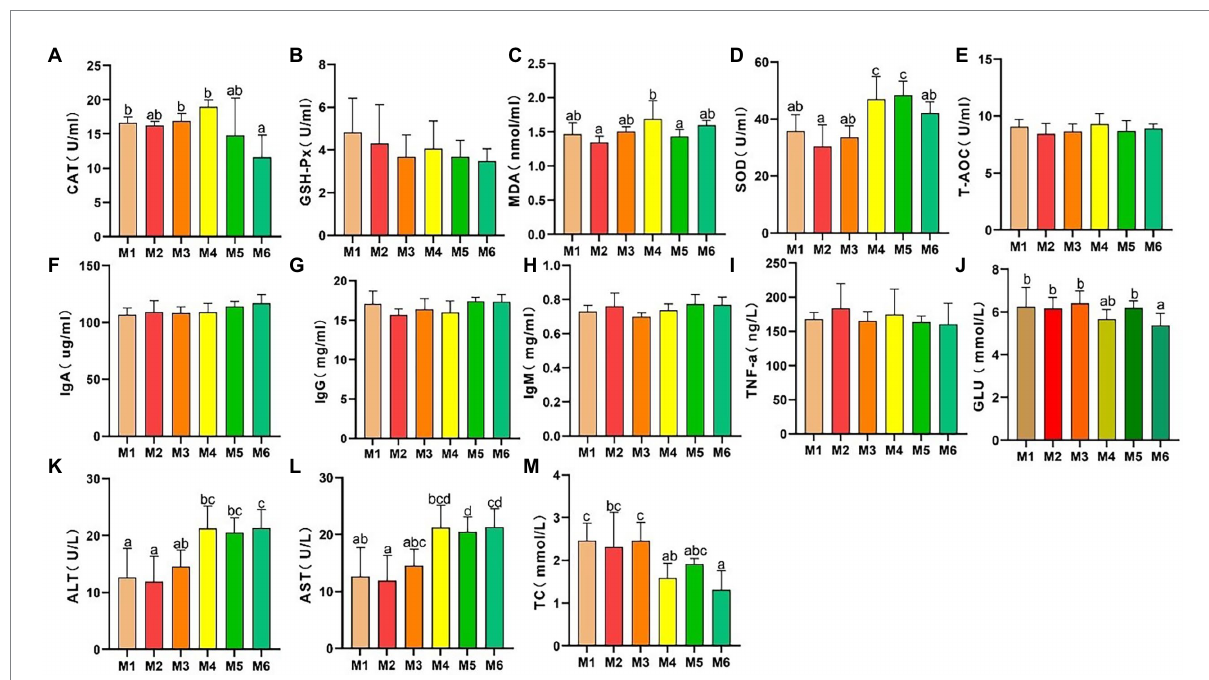
FIGURE 1 Effects of growth stage on serum antioxidant capacity and other biochemical indices in calves in Tibet. The following parameters were analyzed: (A) catalase (CAT) level; (B) glutathione peroxidase (GSH-Px) level; (C) malondialdehyde (MDA) level; (D) superoxide dismutase (SOD) levels; (E) total antioxidant capacity (T-AOC); (F) immunoglobulin (Ig) A level; (G) IgG level; (H) IgM level; (I) tumor necrosis factor α (TNF- α ) level; (J) glucose (GLU) level; (K) alanine transaminase (ALT) level; (L) aspartate transaminase (AST) level; and (M) total cholesterol (TC) level. The results are shown as mean ± SEM. The differences among the six groups are indicated by various letters ( p < 0.05); the number of calves in each of the six groups was